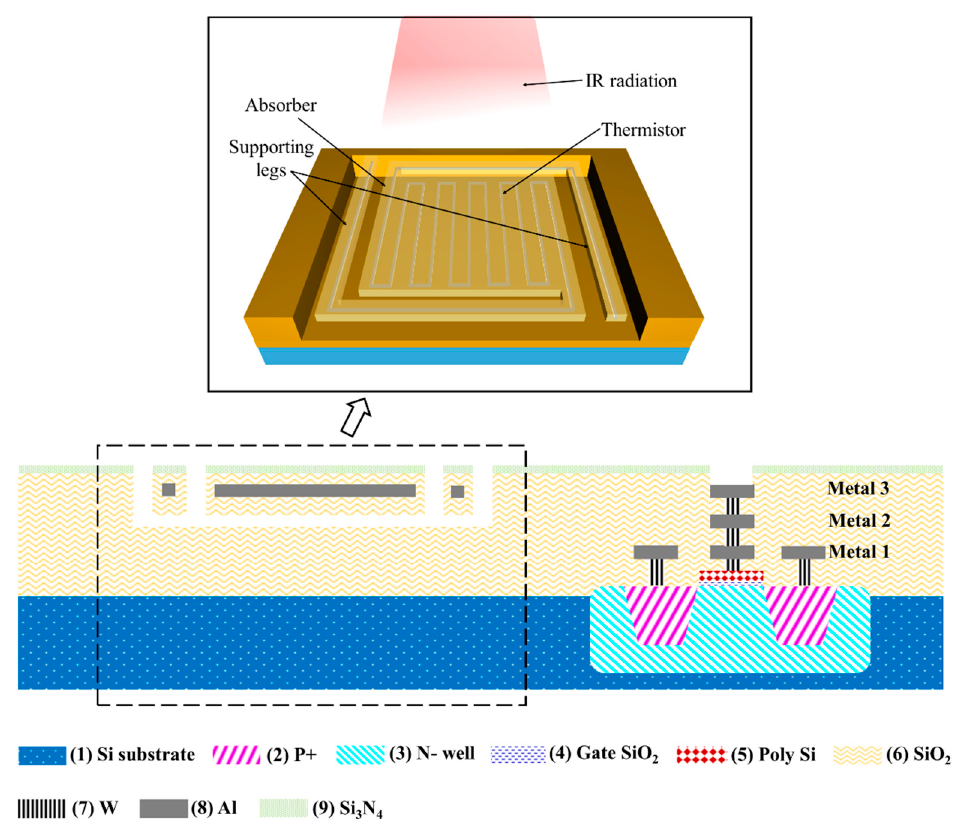
Figure 3. The cross-sectional schematics showing the pixel structure of an aluminum microbolometer. The inset provides a 3D perspective view on the structure of the absorber and the thermistor.